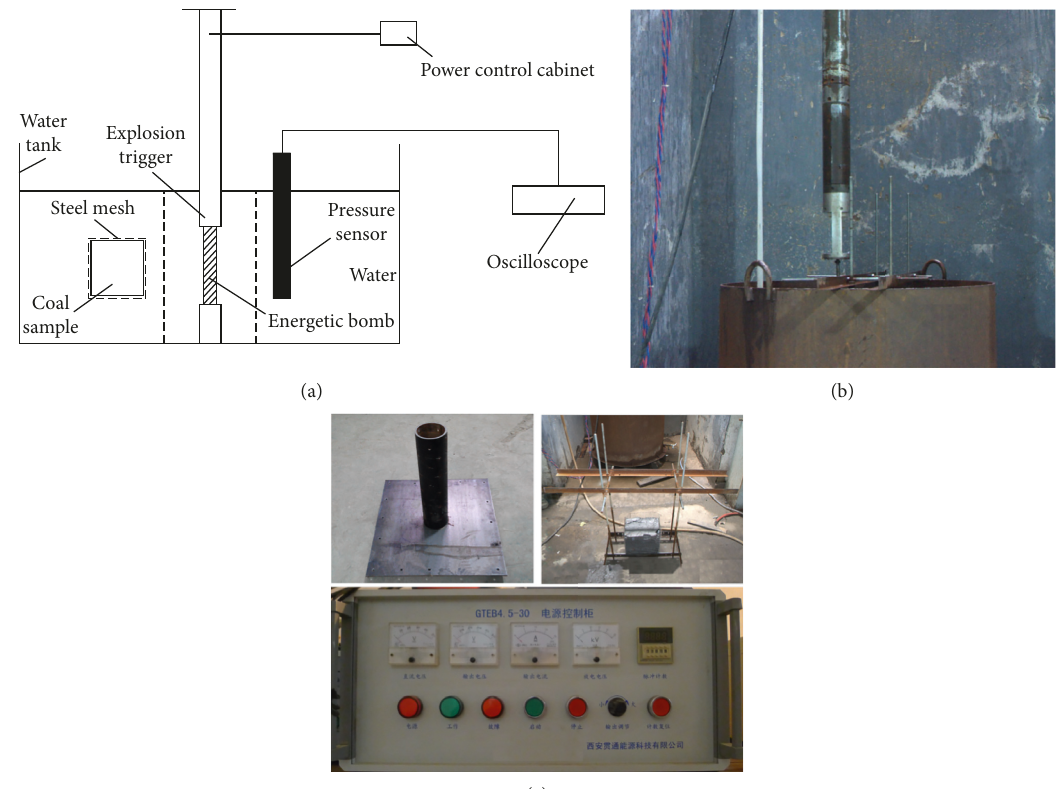
Figure 1: Schematic diagram of an experimental